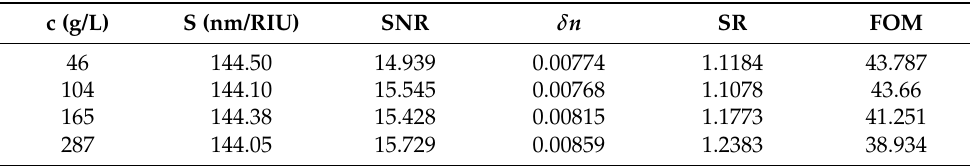
Table 2. Sensitivity, signal to noise ratio, detection limit, sensor resolution, and figure of merit of proposed sensor at various hemoglobin